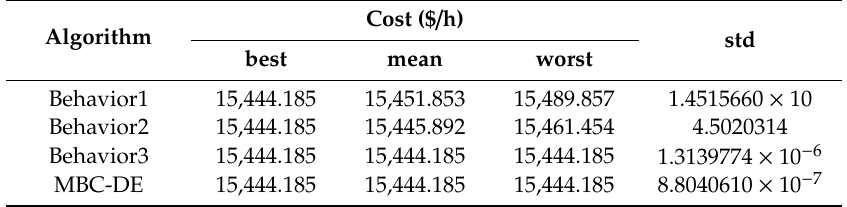
Table 6. Algorithm comparison between multi-behavior and single-behavior for test case 1.